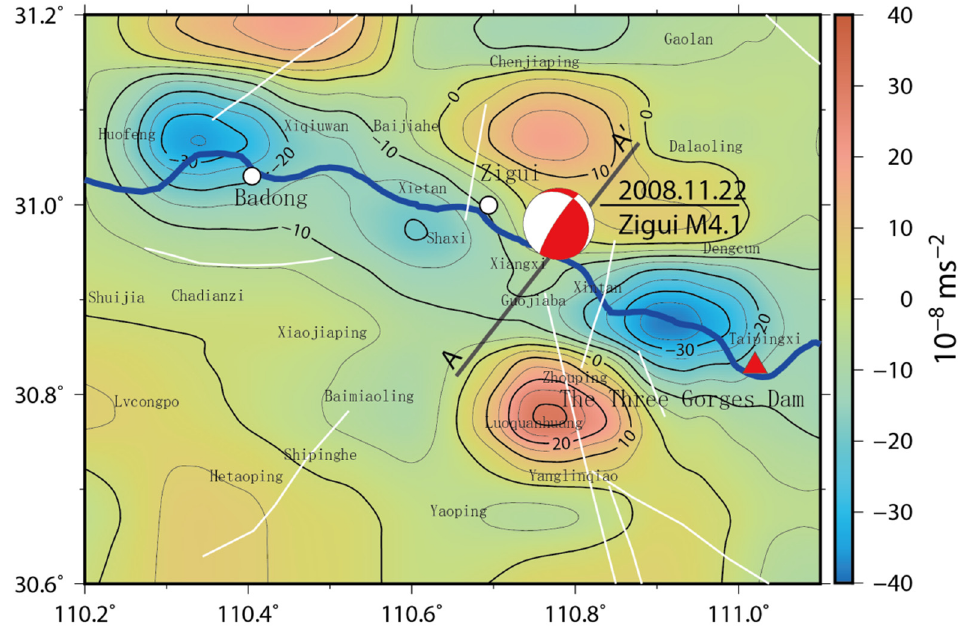
Figure 10. Changes in the gravity field after November 2008 (November 2008–October 2009) and the focal mechanism of the Zigui M4.1 earthquake . focal mechanism of the Zigui M4.1